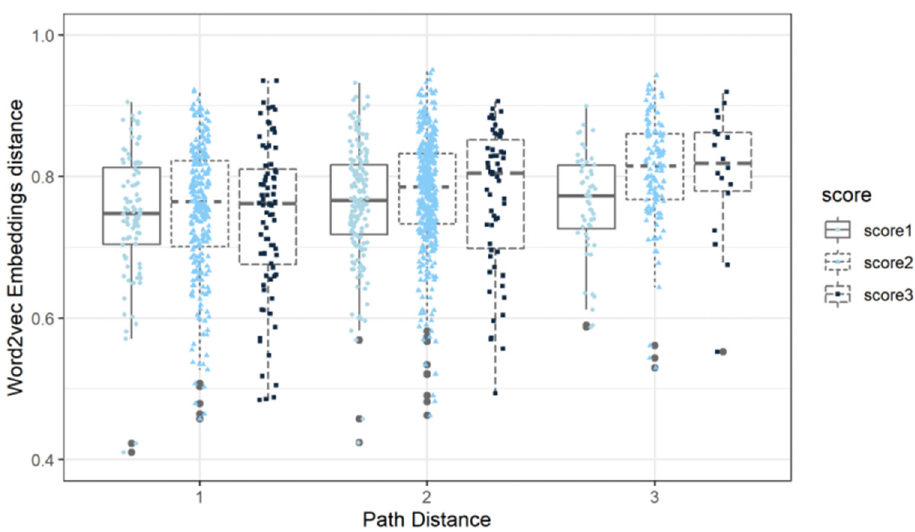
Figure 4. Boxplot for semantic distance and path distance for the given score point; bands corre- sponding to the inference represent 95% of the density interval. The whiskers on the boxes indicate variability outside of the upper and lower quartiles, and the horizontal lines in the boxes indicate the mean semantic distance for the given score point. The distance of each pair of nodes for a given essay is dotted against the x- and y-axes.